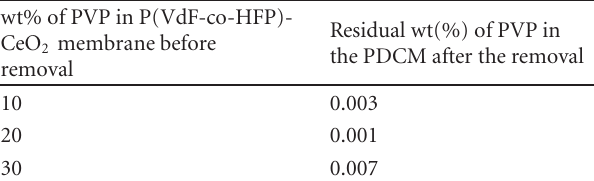
Table 1: Residual weight (%) of PVP after the removal of additive PVP in the composite microporous membranes by preferential polymer dissolution method